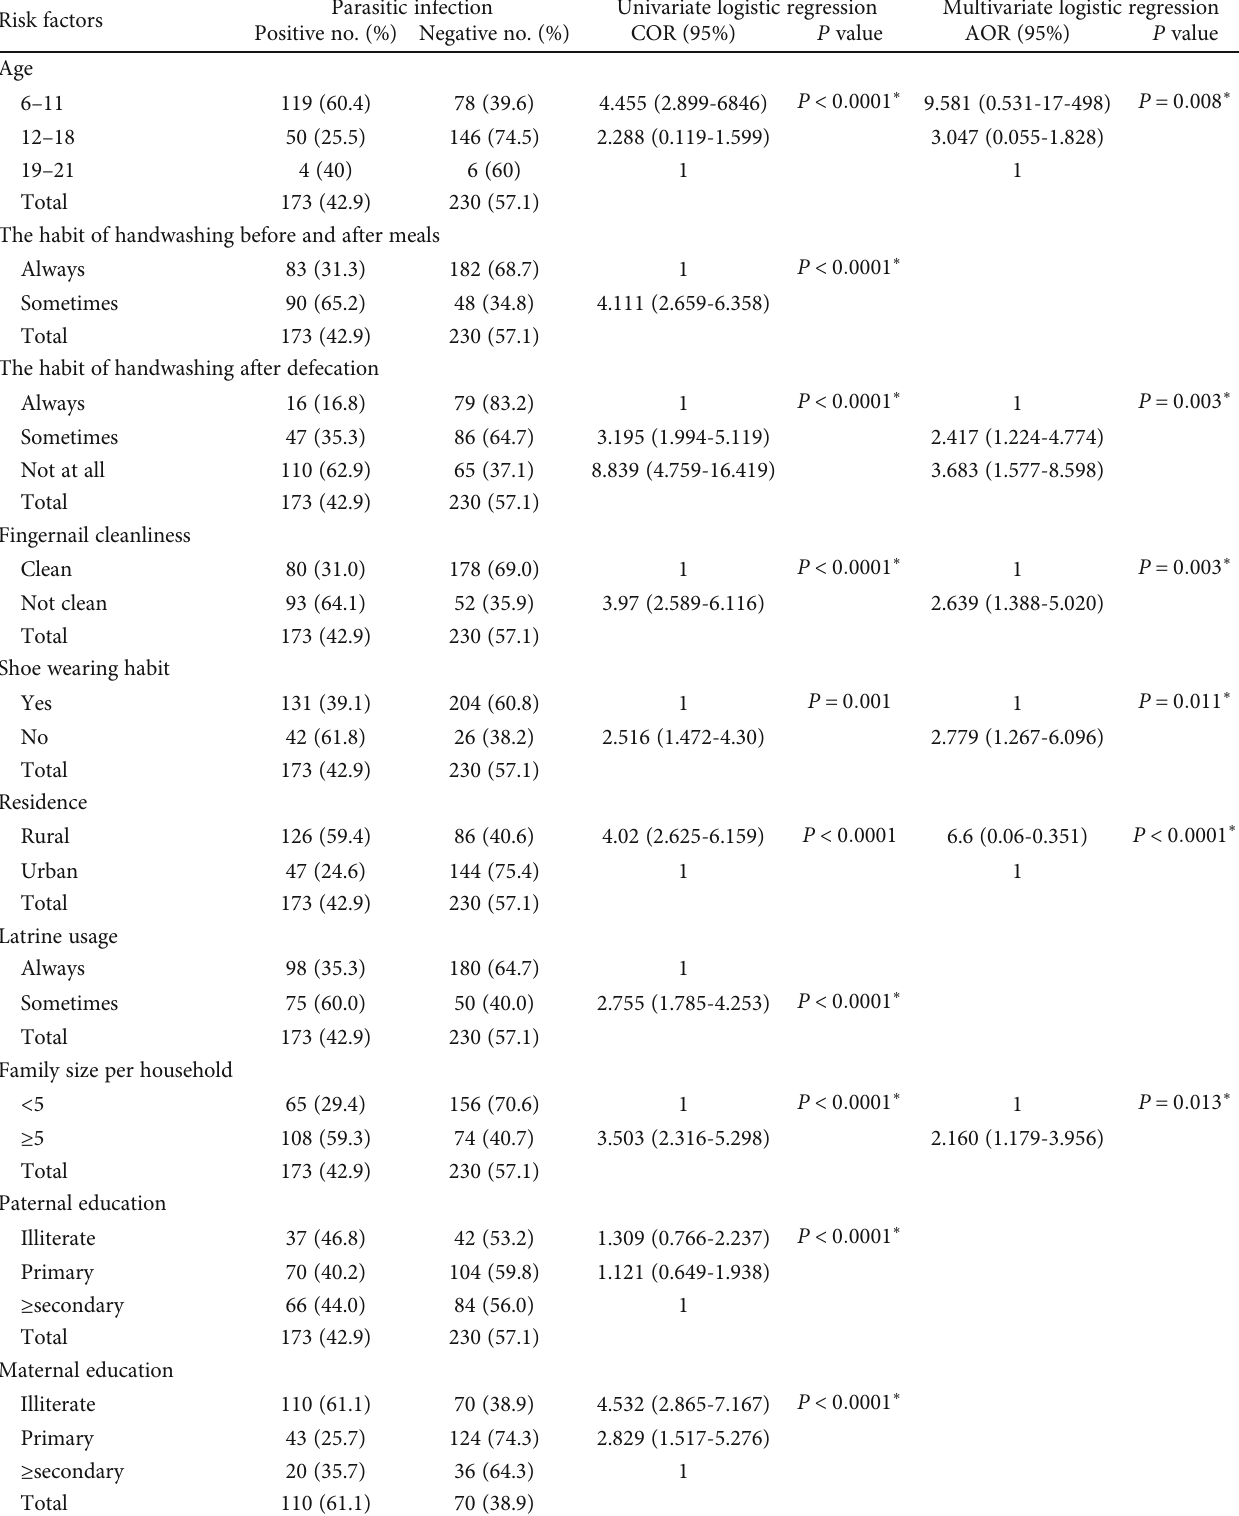
Table 3: Bivariate and multivariate analysis of potential risk factors associated with HIPIs among elementary school children in Merawi